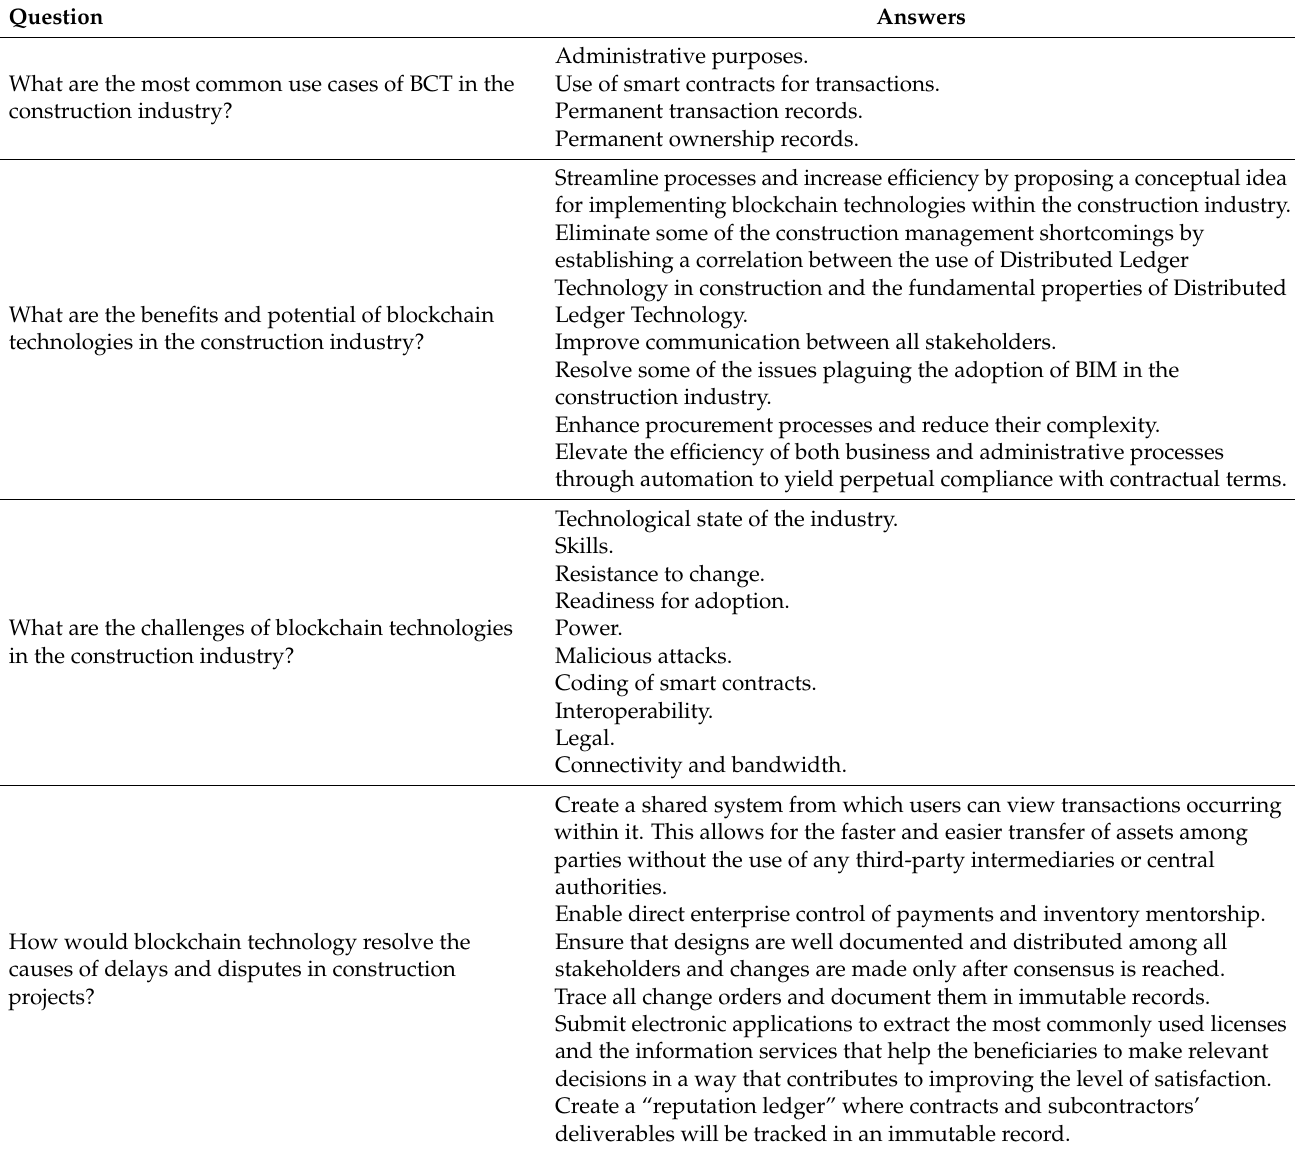
Table 6. The main findings of this